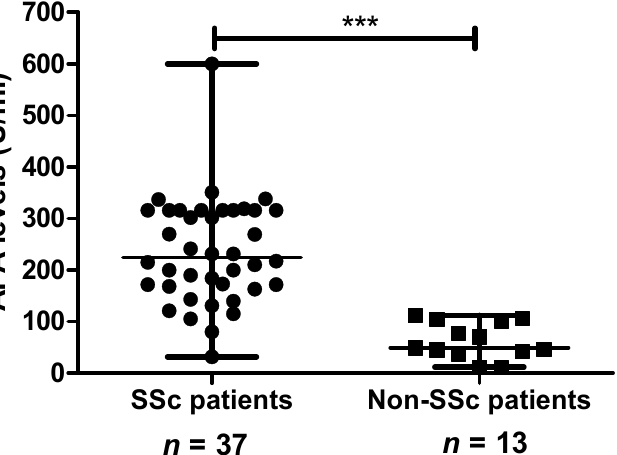
Figure 2. Comparison of antifibrillarin antibody (AFA) levels in AFA-positive systemic sclerosis (SSc) patients ( n = 37) and AFA-positive non-SSc patients ( n = 13). AFA levels were assessed with EliA. Results are expressed as median ± interquartile range. *** p < 0.0001.